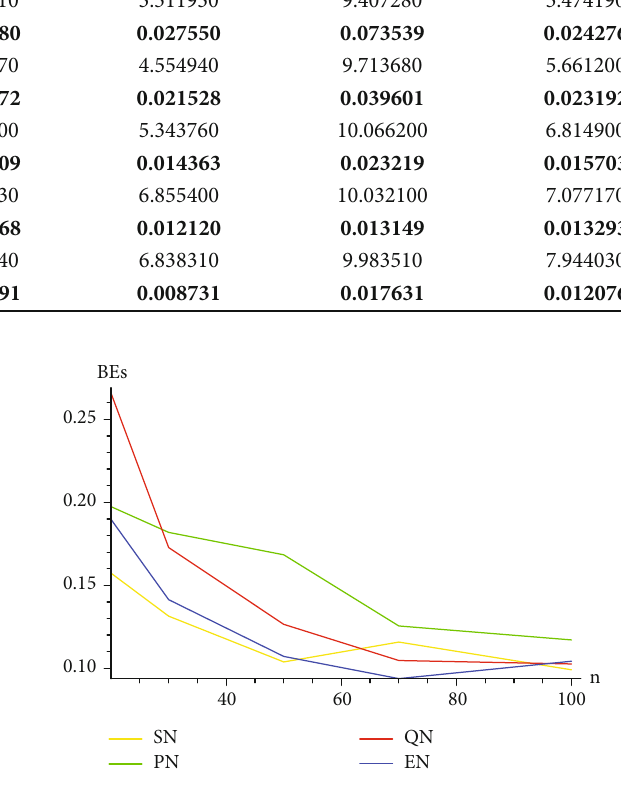
Figure 1: Graph of BEs under di ff erent LFs using NIP for λ = 0 : 1 , using γ = 0 : 1